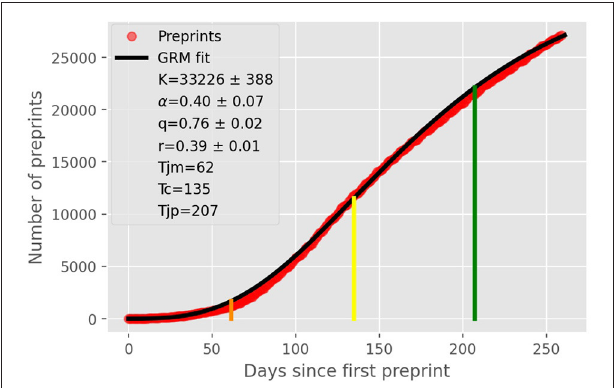
FIGURE 1 | Cumulative number (red circles) of COVID-19 related preprints deposited on online preprint repositories up to September, 30, 2020. The solid black curve is the fit to the empirical data by the generalized Richards model, with the parameters shown in the legend box. The vertical lines indicate the location of some key characteristic points of the theoretical curve, as follows: (i) point of maximum acceleration t − j = 62 (orange line); (ii) inflection point t c = 135 (yellow line); and (iii) point of maximum deceleration t + j = 207 (green line).